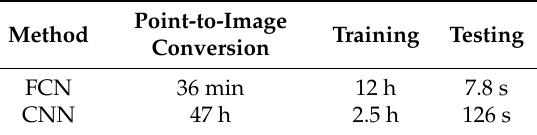
Table 10. Computational time comparison. Computer specifications: Intel Core i7-6700HQ